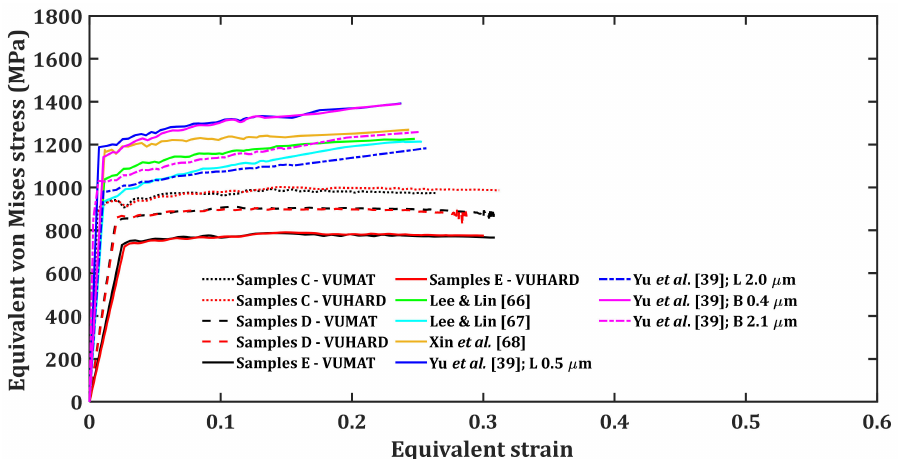
Figure 12. Results of SHPB test simulation at an impact velocity of 8 m/s and a temperature of 25 ◦ C with the test samples modelled using various sets of J–C model parameters (note: B and L stand for bimodal and lamellar microstructures, respectively) and the numerical models developed in the present work.